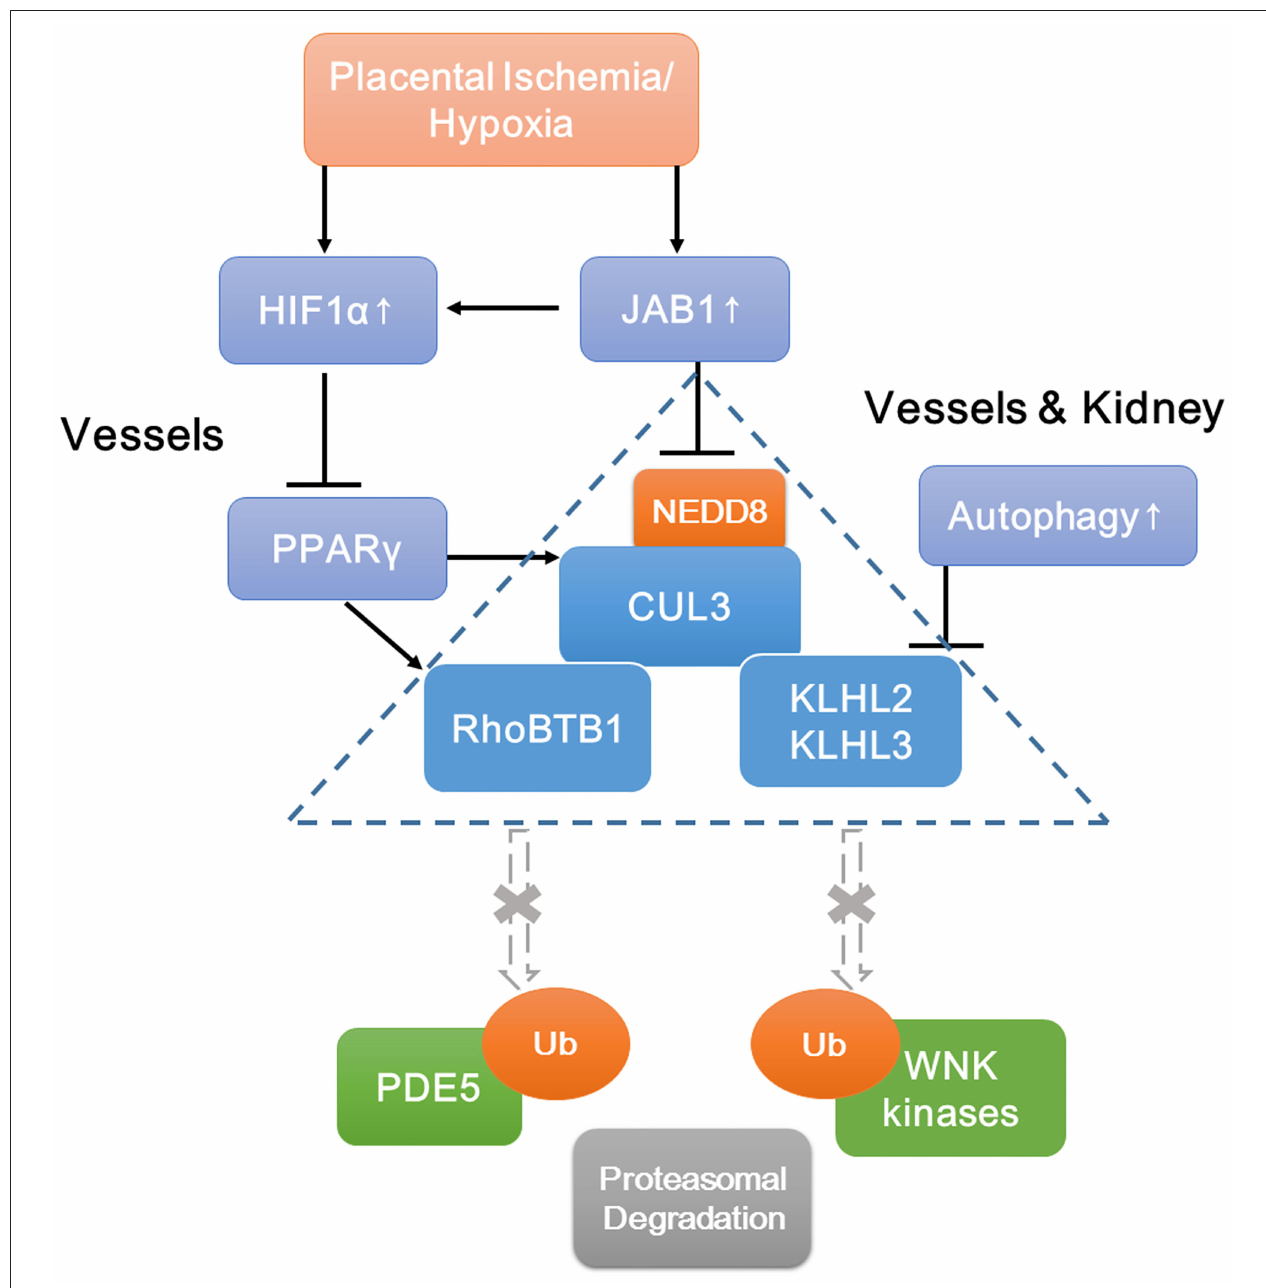
FIGURE 7 | Schematic view of molecular mechanisms of accumulation of WNK kinases and PDE5 under preeclampsia. Increased JAB1 abundance stabilizes HIF1 α and upregulates its expression under ischemia/hypoxia. Increased HIF1 α decreases PPAR γ expression and then downregulates CUL3 abundance. Upregulated CSN also causes lower CUL3 neddylation. Decreased abundance and neddylation of CUL3 lead to CUL3 dysfunction. Increased autophagy promotes degradation of adaptors KLHL3/2, and decreased abundance of PPAR γ downregulates adaptor RhoBTB1 expression. Subsequent accumulation of substrates including WNK kinases and PDE5 results in the abnormal vasoconstriction and vasodilation and NCC activation. JAB1, a component of the COP9 signalosome; HIF1 α , hypoxia-inducible factor 1 α ; PPAR γ , peroxisome proliferator–activated receptor γ . under CUL3; meanwhile, upregulated CSN also causes lower CUL3 neddylation, both of which contribute to CUL3